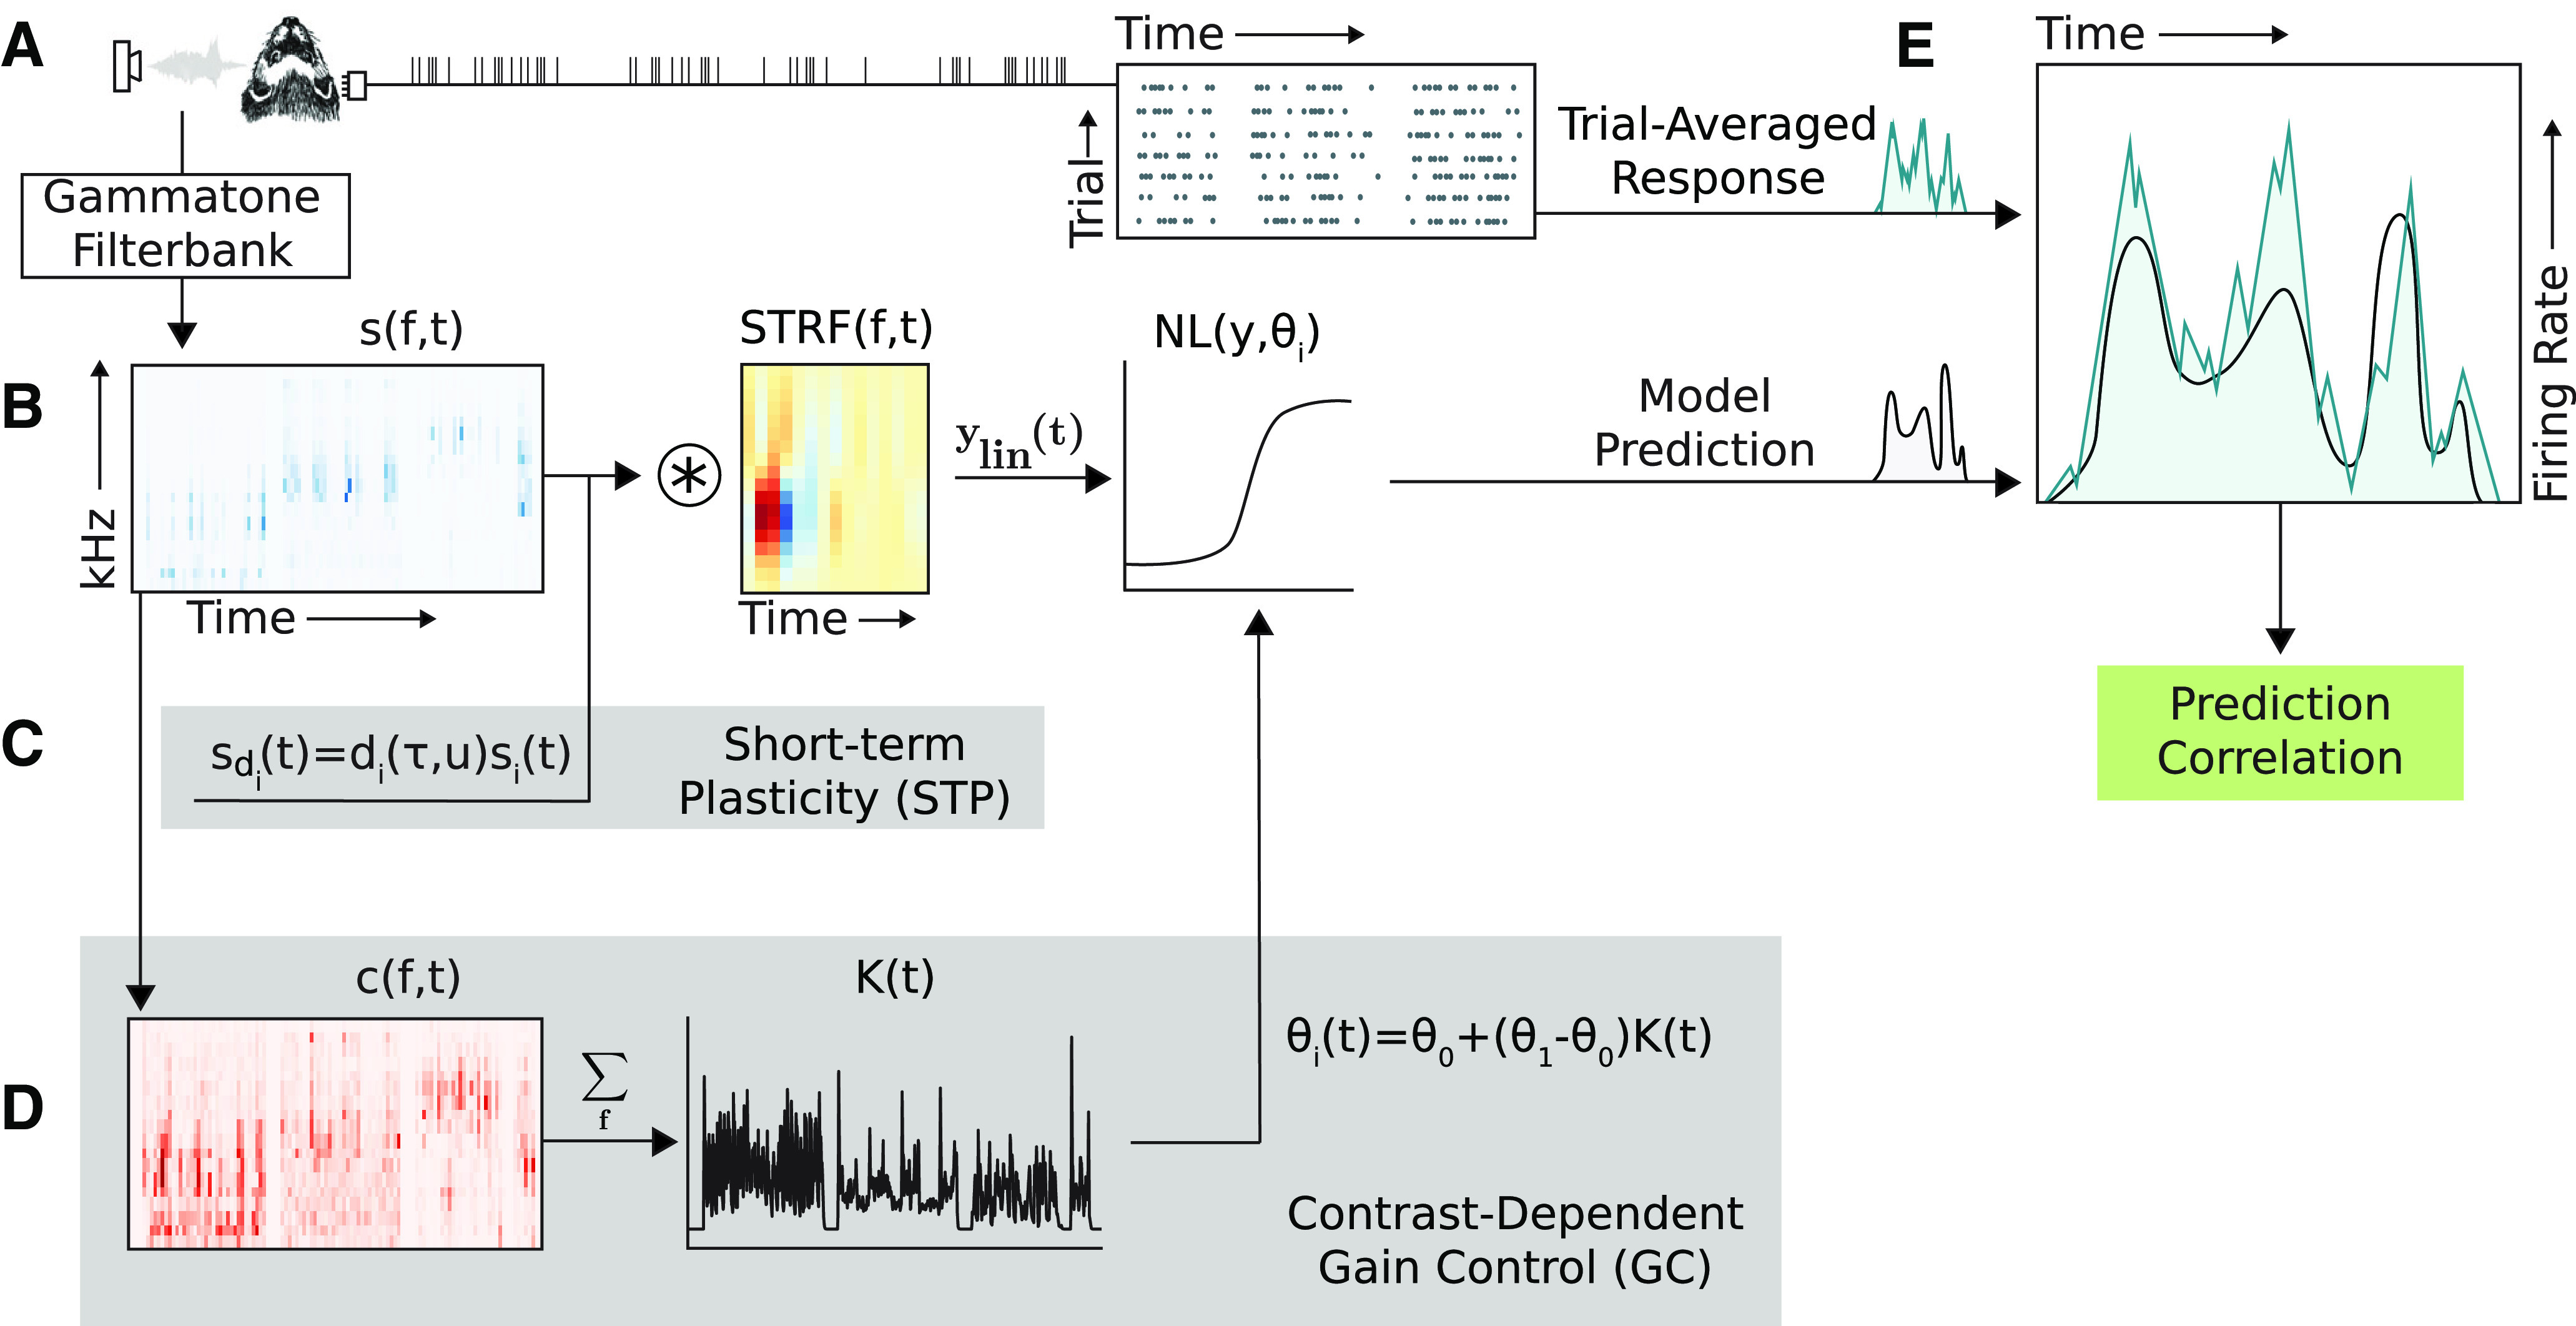
Schematic of four different model architectures for sound encoding by neurons in auditory cortex. A, Single neuron activity was recorded from A1 of awake, passively listening ferrets during presentation of a large set of natural sound stimuli. The trial-averaged response to each sound was calculated as the instantaneous firing rate using 10-ms bins. Sound waveforms were transformed into 18-channel spectrograms with log-spaced frequencies for input to the models. B, Linear nonlinear (LN) model: stimulus spectrogram is convolved with a linear spectro-temporal filter followed by nonlinear rectification. C, Short-term plasticity (STP) model: simulated synapses depress or facilitate spectral stimulus channels before temporal convolution. D, Gain control (GC) model: the coefficient of variation (contrast) of the stimulus spectrogram within a rolling window is summed across frequencies. Parameters for the nonlinear rectifier are scaled by time-varying contrast. E, Model performance is measured by the correlation coefficient (Pearson’s R) between the trial-averaged response and the model prediction. The four architectures were defined as follows: LN, B only; STP, B and C; GC, B and D; GC+STP, B–D.